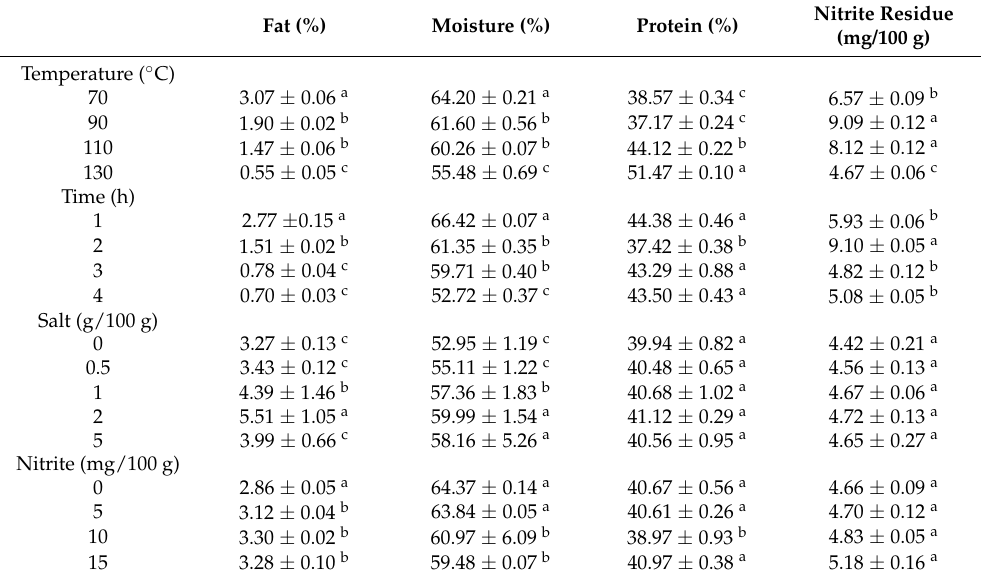
Table 2. Proximate composition content during sausage processing.